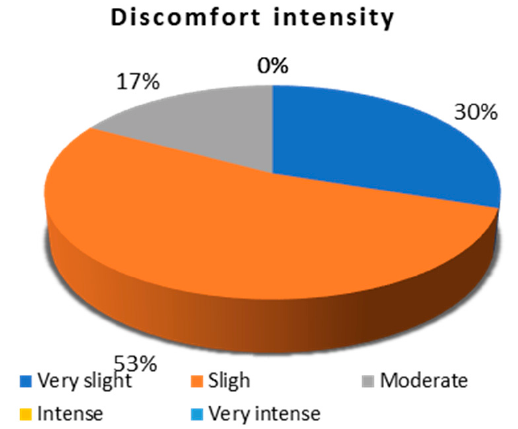
Figure 25. Discomfort intensity under smoke-filled environment.